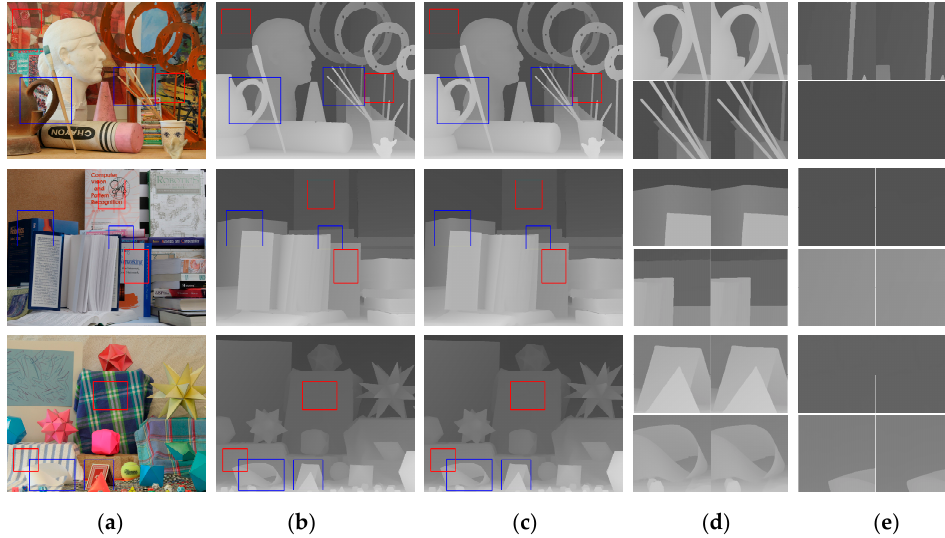
Figure 3. Upsampled depth maps for dataset A with an upscaling factor of 8. ( a ) HR RGB images for input, ( b ) ground-truth HR depth maps, ( c ) upsampled results from our network, ( d ) regions inside blue boxes from ( b ) (left) and ( c ), and ( e ) regions inside red boxes from ( b ) (left) and ( c ).